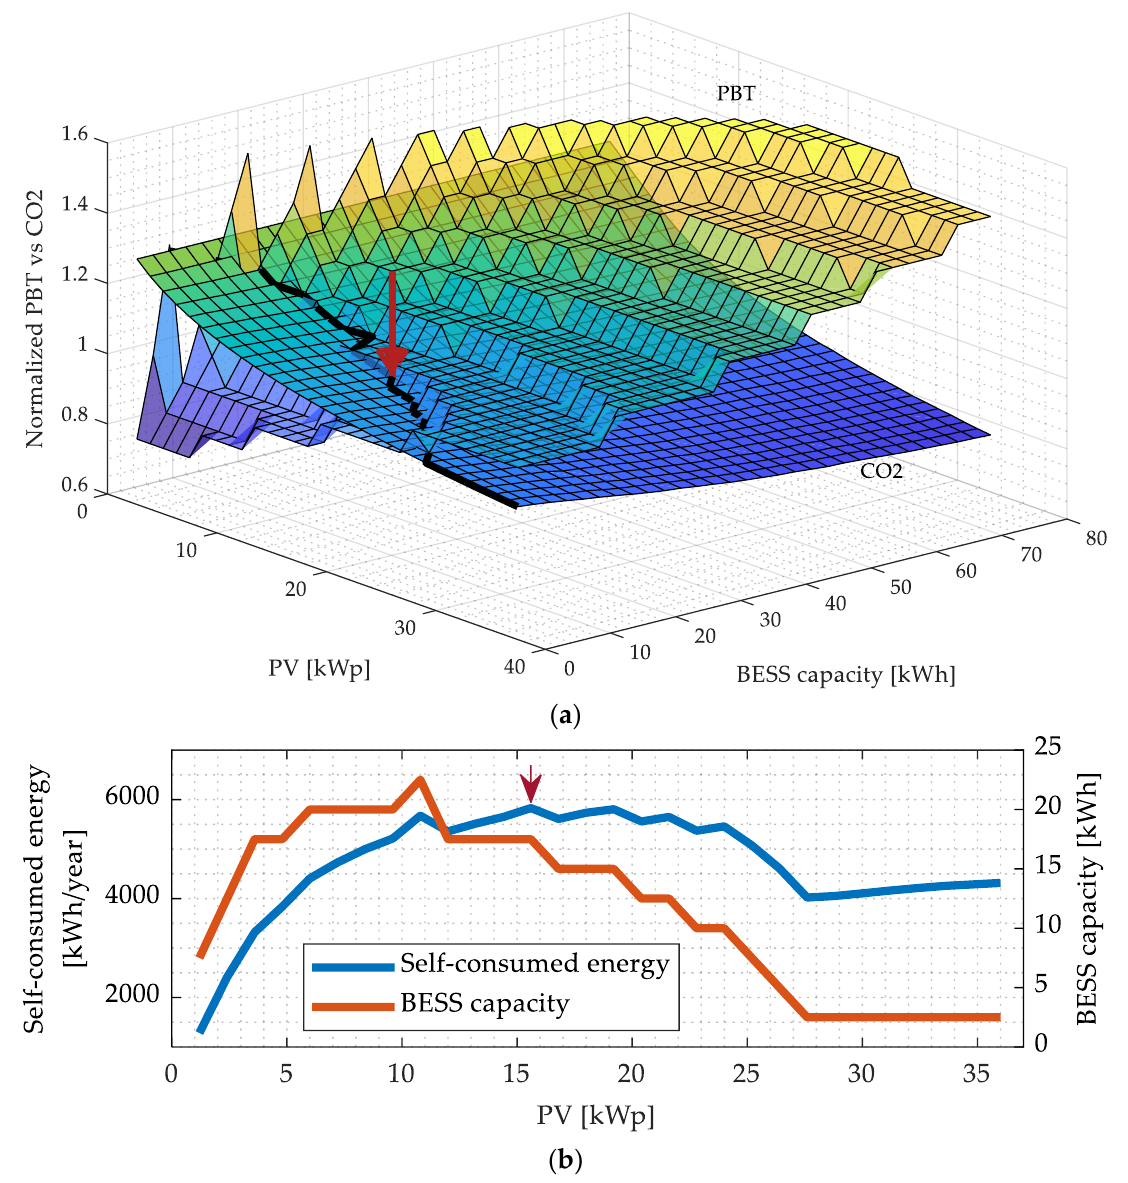
Figure 5. ( a ) Normalised PBT vs. total CO2 emissions for Scenario 3 . The black line represents the intersection of the two surfaces; ( b ) total self-consumed energy values and BESS capacity for the trade-off points considered for Scenario 3.